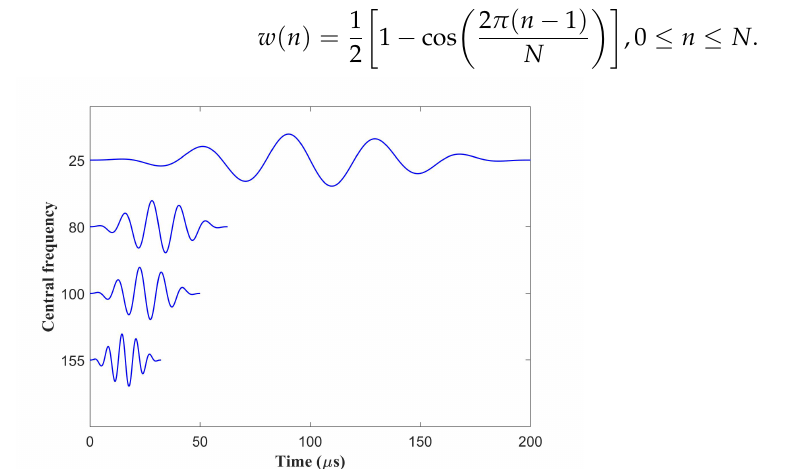
Figure 11. The Hanning windowed sinusoidal